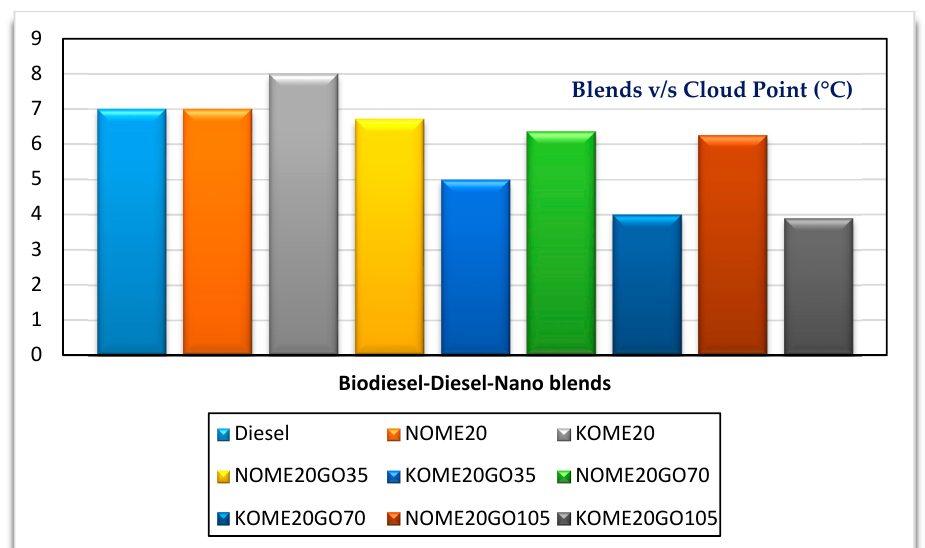
Figure 8. Variation of cloud point with Biodiesel-Diesel-Nano blends.